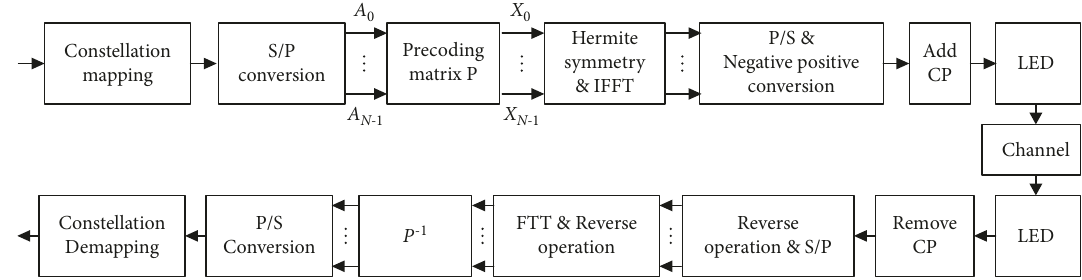
Figure 2: The structure chart of classical precoding technology in the VLC-based intelligent transportation